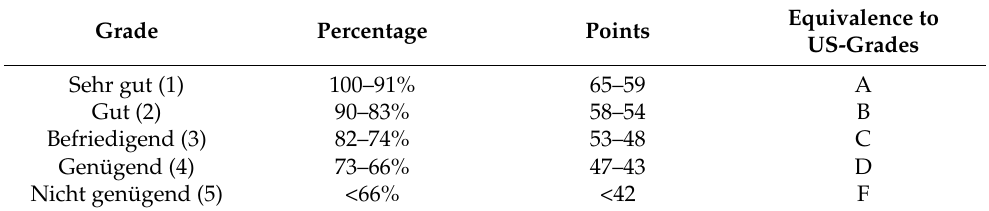
Table 1. Equivalence key for grades according to achieved points in formative integrative test (FIT) 1 .